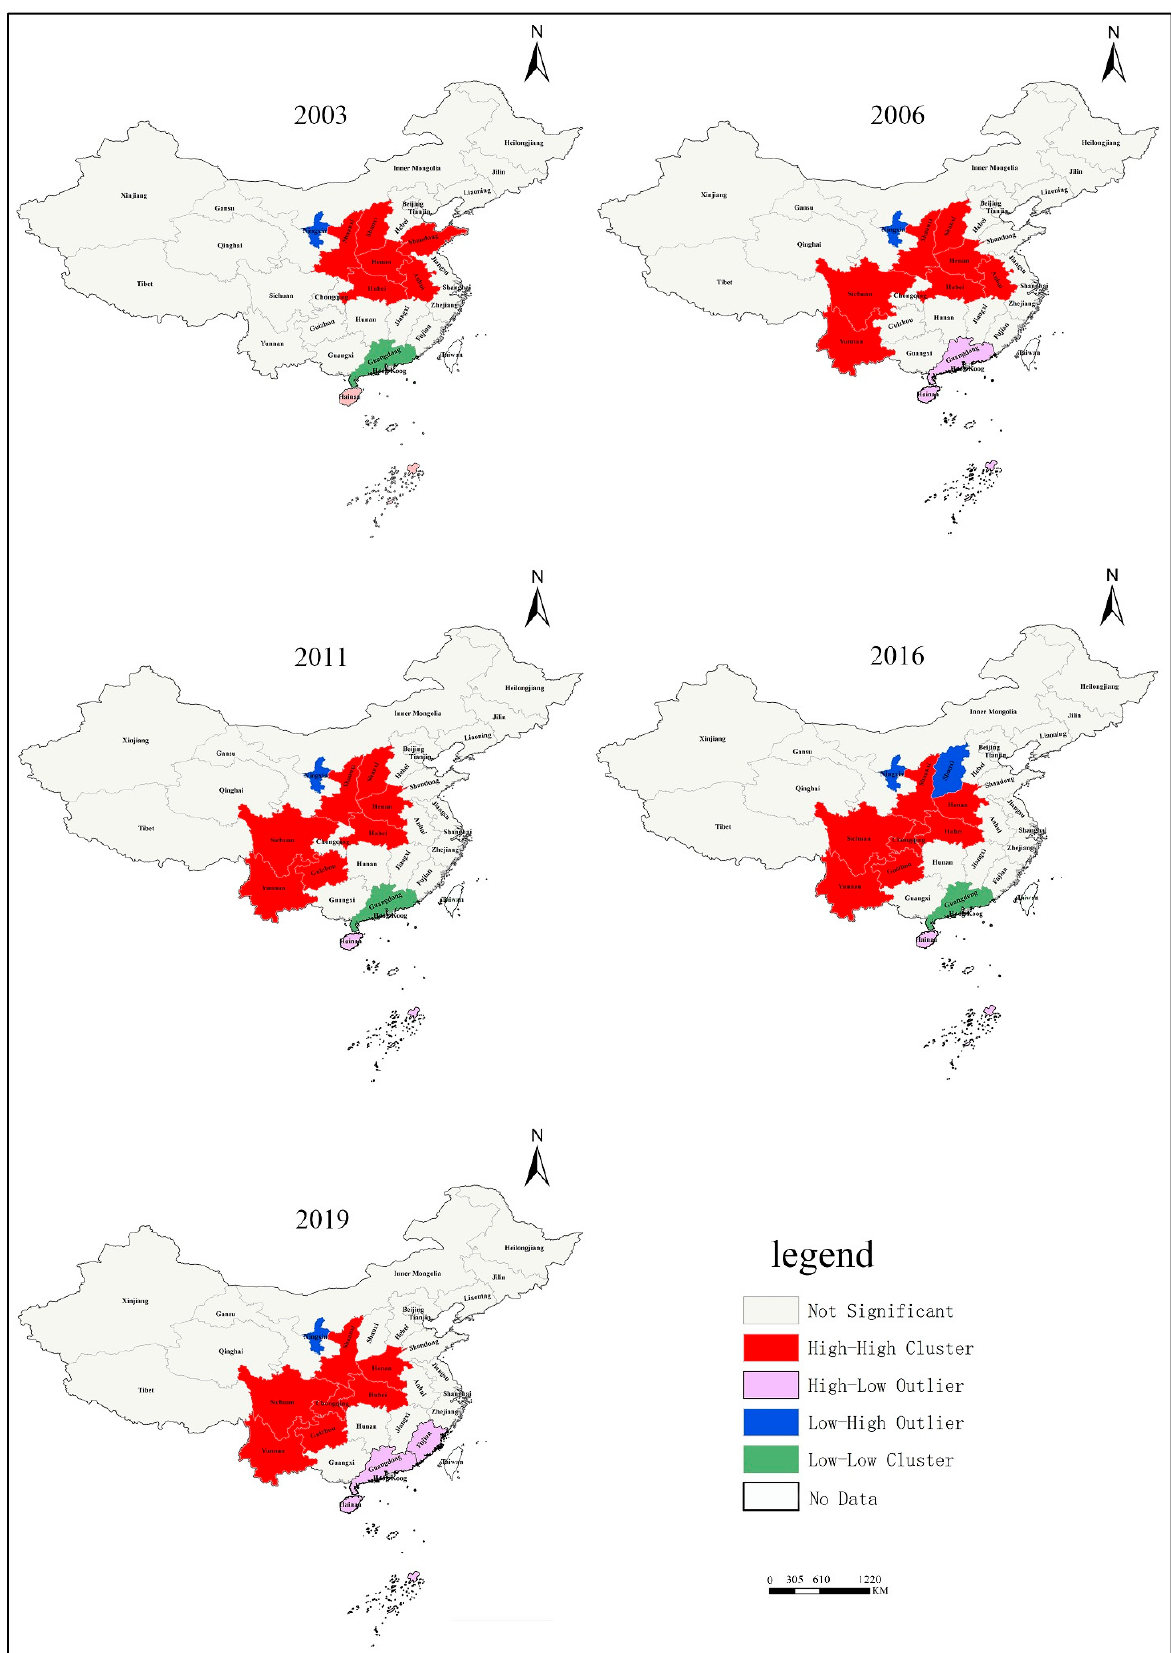
Figure 4. Local spatial pattern characteristics of the output intensity of agricultural water.